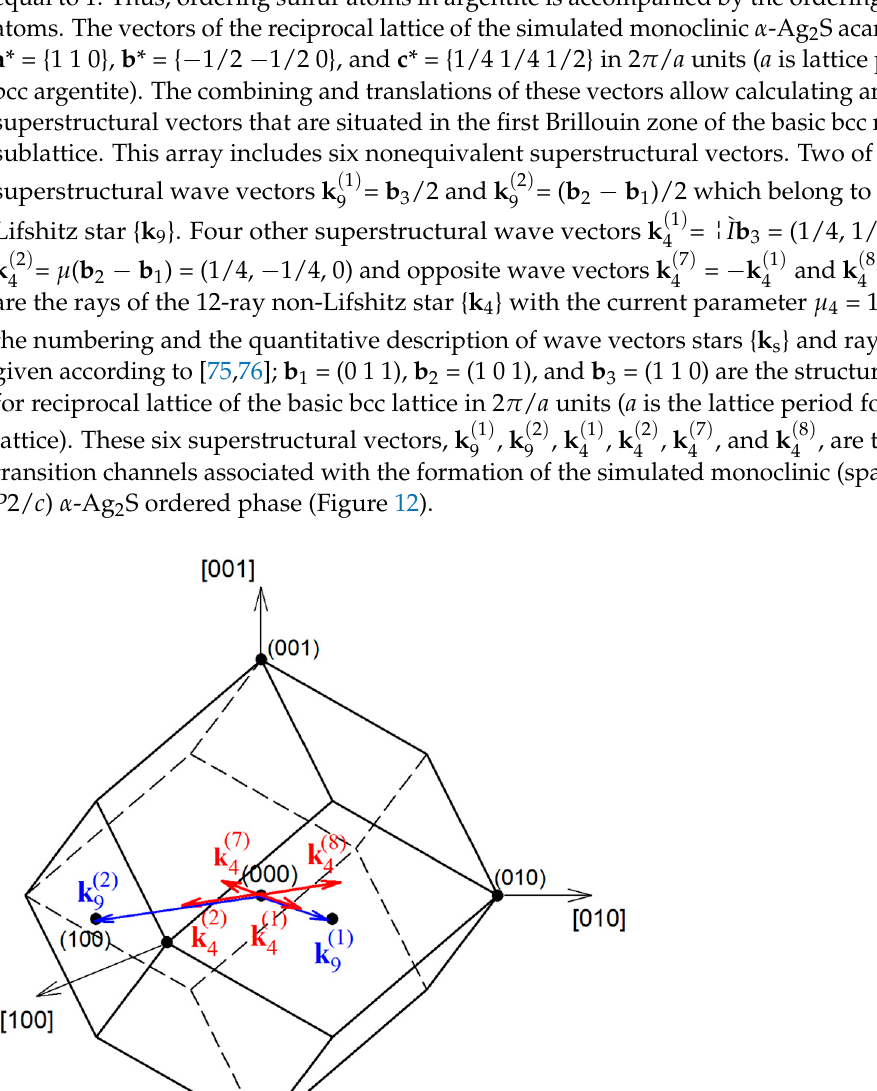
Figure 12. Positions of six superstructural wave vectors k simulated monoclinic ordered phase α -Ag 2 S in the first Brillouin zone of the bcc lattice. Thus, the “argentite–acanthite” transformation can be discussed as a disorder–order transition in both (nonmetallic and metallic) sublattices of cubic argentite, complicated by atomic static displacements. This transformation occurs with a distortion of cubic symmetry of argentite for the Lifshitz star { k 9 } and the non-Lifshitz star { k 4 }. The presence of the rays of a non-Lifshitz star in the phase transition channel means that the transformation “ β -Ag 2 S— α -Ag 2 S” does not fulfill the Landau group-theoretical criterion for second-order phase transformations. Therefore, the transformation “ β -Ag 2 S— α -Ag 2 S” occurs on the first-order transition